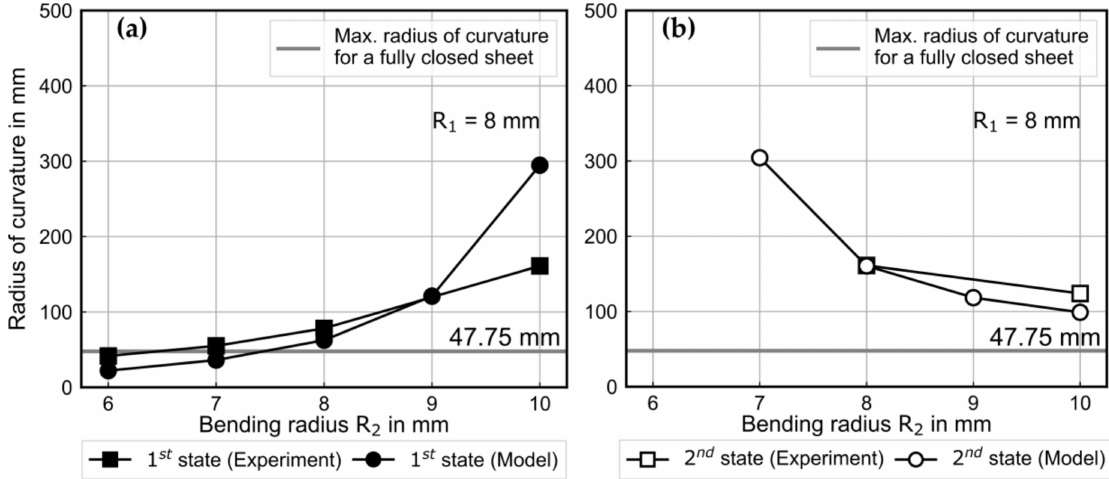
Figure 14. Radii of curvature for first ( a ) and second ( b ) stable state after first bending operation with a radius R 1 = 8 mm and various second bending radii R 2 .